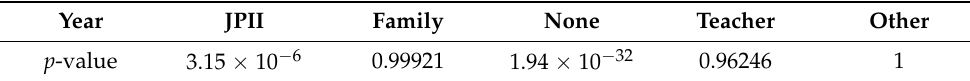
Table 4. Summary of prop.test: Alternative